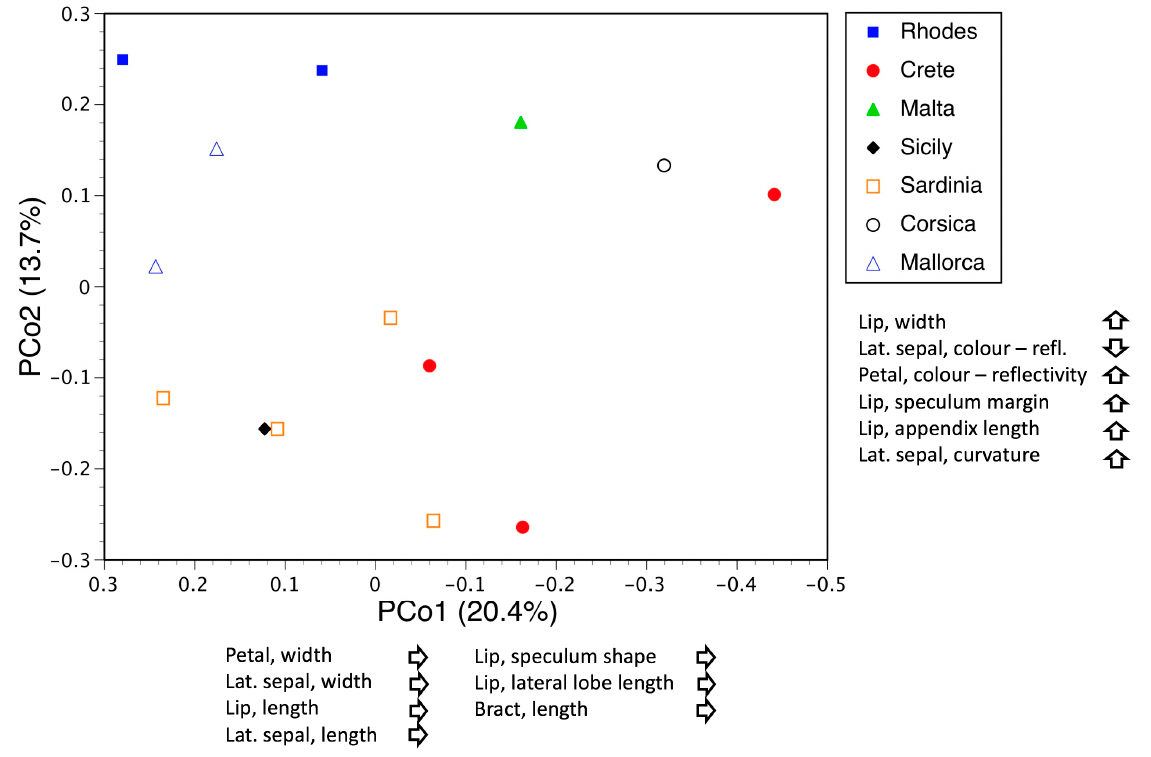
Figure 13. Plot of principal coordinates 1 and 2 for the macrospecies Bombyliflora, labelled according to four regions of origin: 14 individuals from 14 localities and 47 variable characters. Characters contributing to each coordinate are listed in descending order, with arrows indicating the direction of increase in the value of each character.